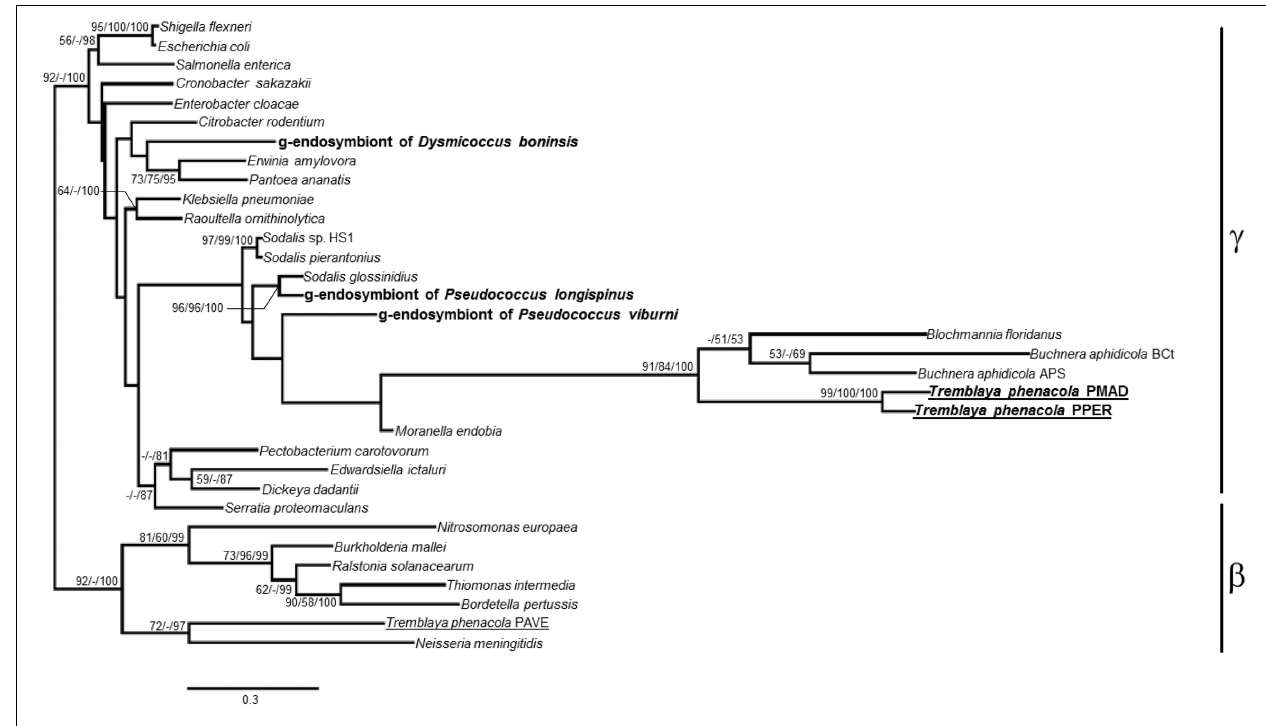
FIGURE 2 | ML phylogenetic analysis of the trpB partial nucleotide sequences obtained from P. peruvianus and P. madeirensis samples. Sequences obtained in this work are in bold; those from the Phenacoccinae